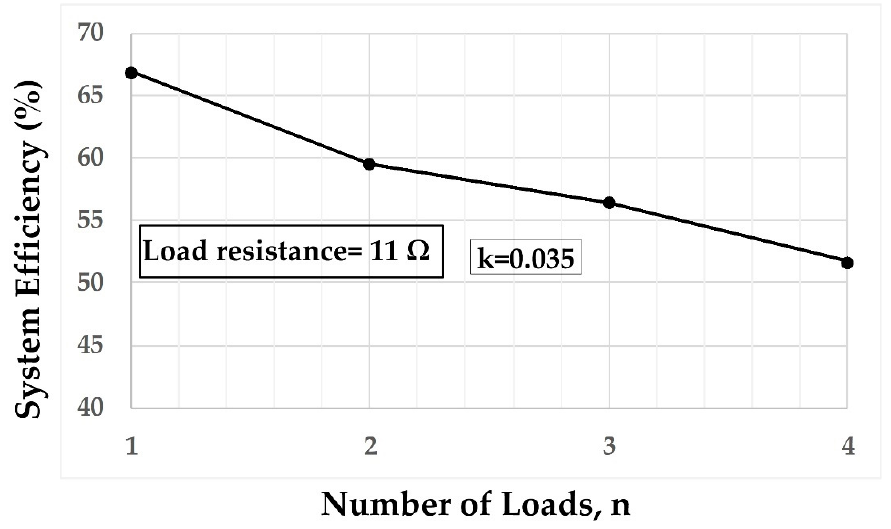
Figure 13. System efficiency against the number of loads.